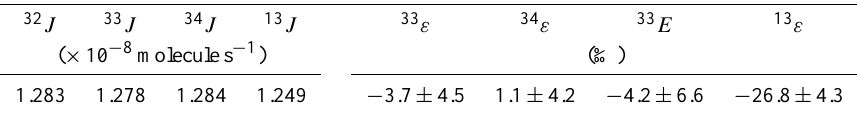
Table 3. Photolysis rate of each OCS isotopologues at 20km altitude ( 32 / 33 / 34 / 13 J ) and isotope fractionation constants ( 33 / 34 ε and 13 ε ) and non-mass-dependent fractionation constant ( 33 E